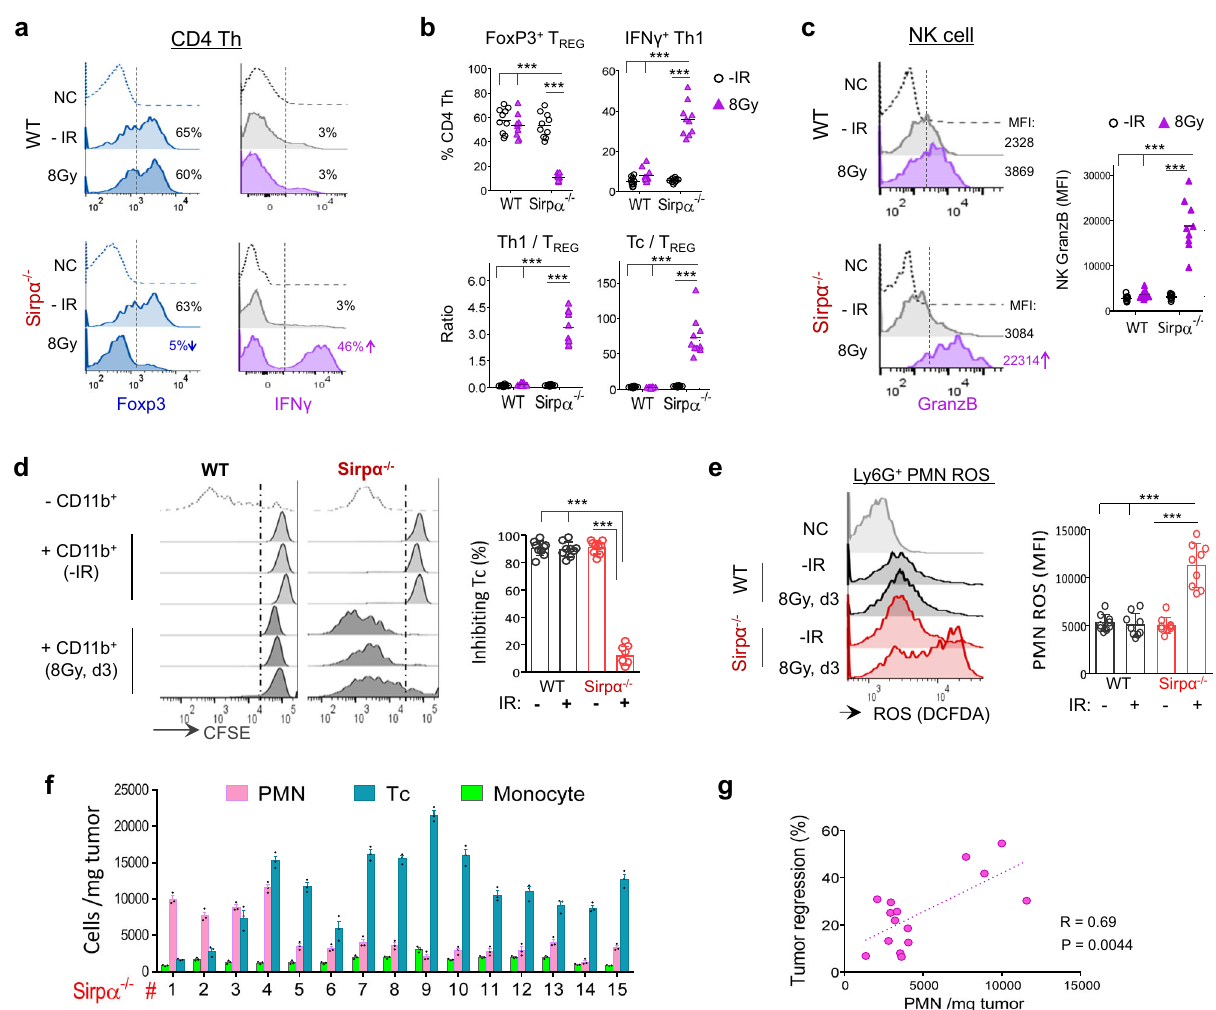
Fig. 5 Reshaping the immunosuppressive TME in Sirp α − / − mice into a proin fl ammatory tumoricidal niche post-IR. a , b Foxp3 + Tregs and IFN γ + Th1 among the total intratumoral CD4 Th cells. Data are representative of three independent experiments (3 – 4 mice/group in each experiment). n = 10 mice in each group. *** P < 0.001. c NK cells and their GranzB expression. Left, representative image from three independent experiments showing the mean fl uorescent intensity (MFI) of GranzB in intratumoral NK cells. Right, statistical analysis of GranzB MFI in intratumoral NK cells). *** P < 0.001. d Isolated total intratumoral myeloid cells were tested for inhibition of T cell proliferation. e ROS production by tumor in fi ltrated PMN in the presence of DCFDA and 1 μ M PMA. Data from three independent experiments are presented as mean ± SEM. n = 9 mice in each group ( c – e ). *** P < 0.001. f , g In fi ltrated PMNs promote tumor regression in Sirp α − / − mice. Large quantities of intratumoral PMN and other leukocytes were detected in most of the fi fteen MC38 tumors in Sirp α − / − mice collected 3 days post-IR ( f ), and intratumoral PMN quantity positively correlated with the degree to which tumors had regressed by 3 days post-IR ( g ). Cell numbers were counted in triplicate and presented as mean ± SEM. Data are representative of three independent experiments. n